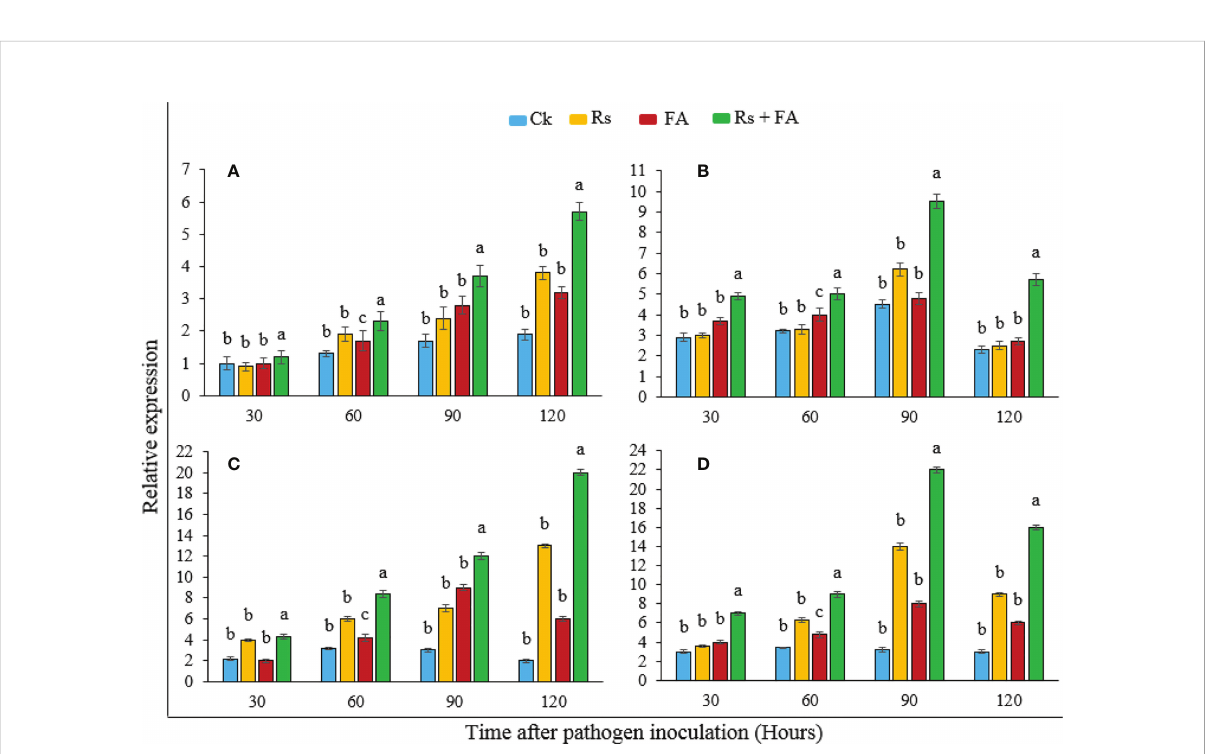
FIGURE 4 Relative expression of defense-related genes of tomato plants treated with furoic acid compound at different durations after pathogen inoculation. (A) PAL , (B) LOX , (C) PR1 , and (D) PR2 . Bars represent the standard error. Lower case lettering shows the signi fi cant difference among the